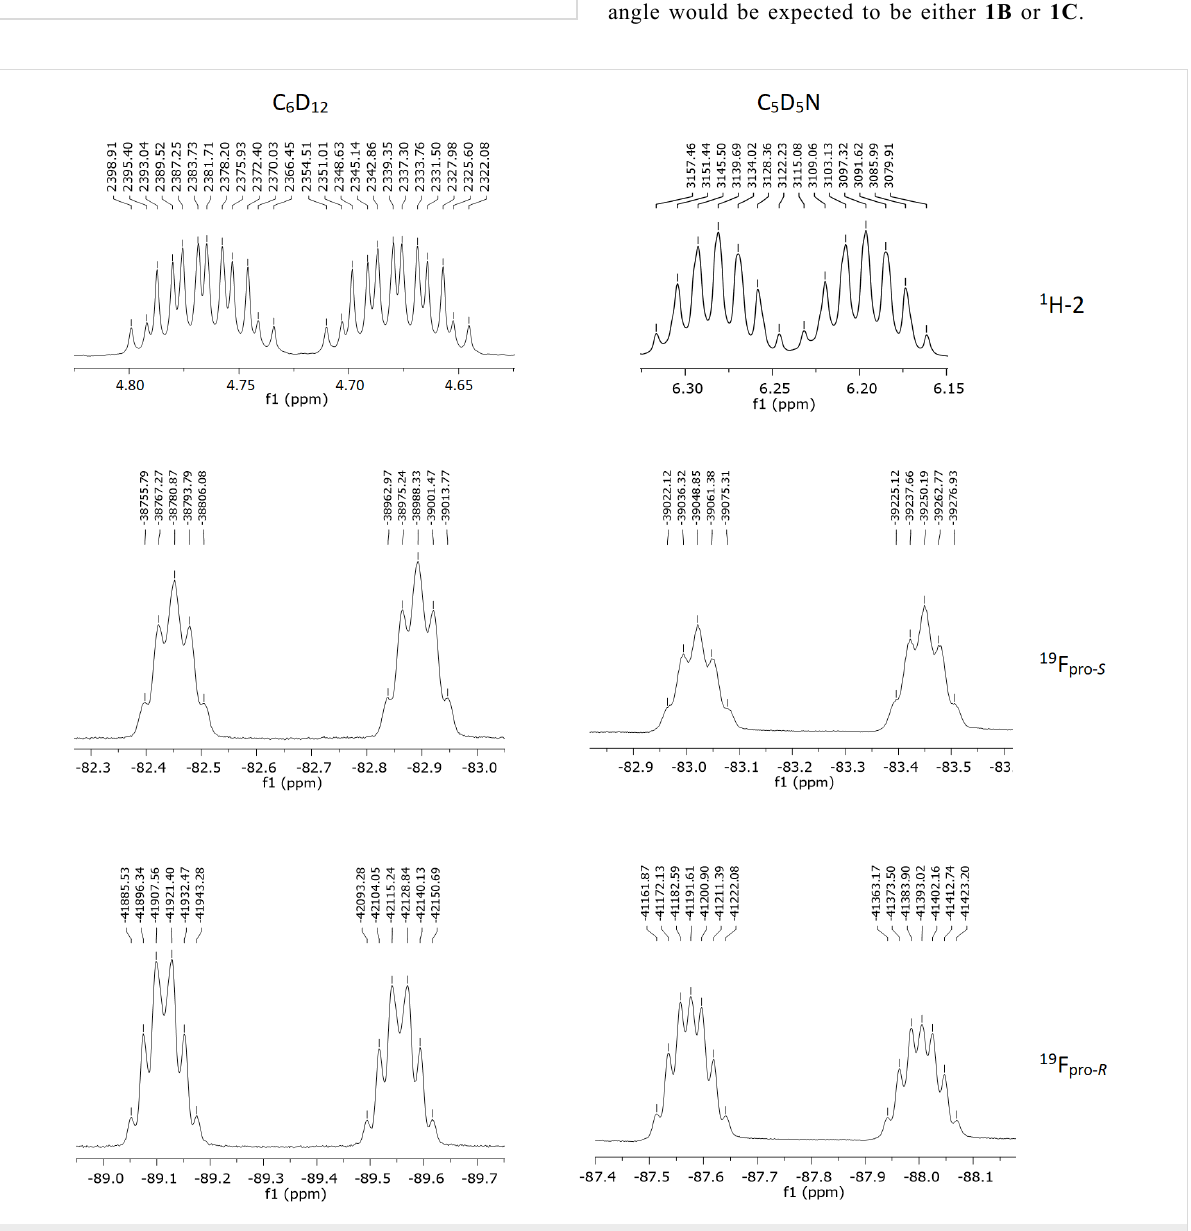
Figure 2: Expansion of the 1 H and 19 F NMR spectra in the region of C H F and C F 2 , in C 6 D 12 and C 5 D 5 N solvents. The 19 F chemical shifts were assigned taking into consideration the signal split patterns, coupling constants and possible geometries for the stable conformers.